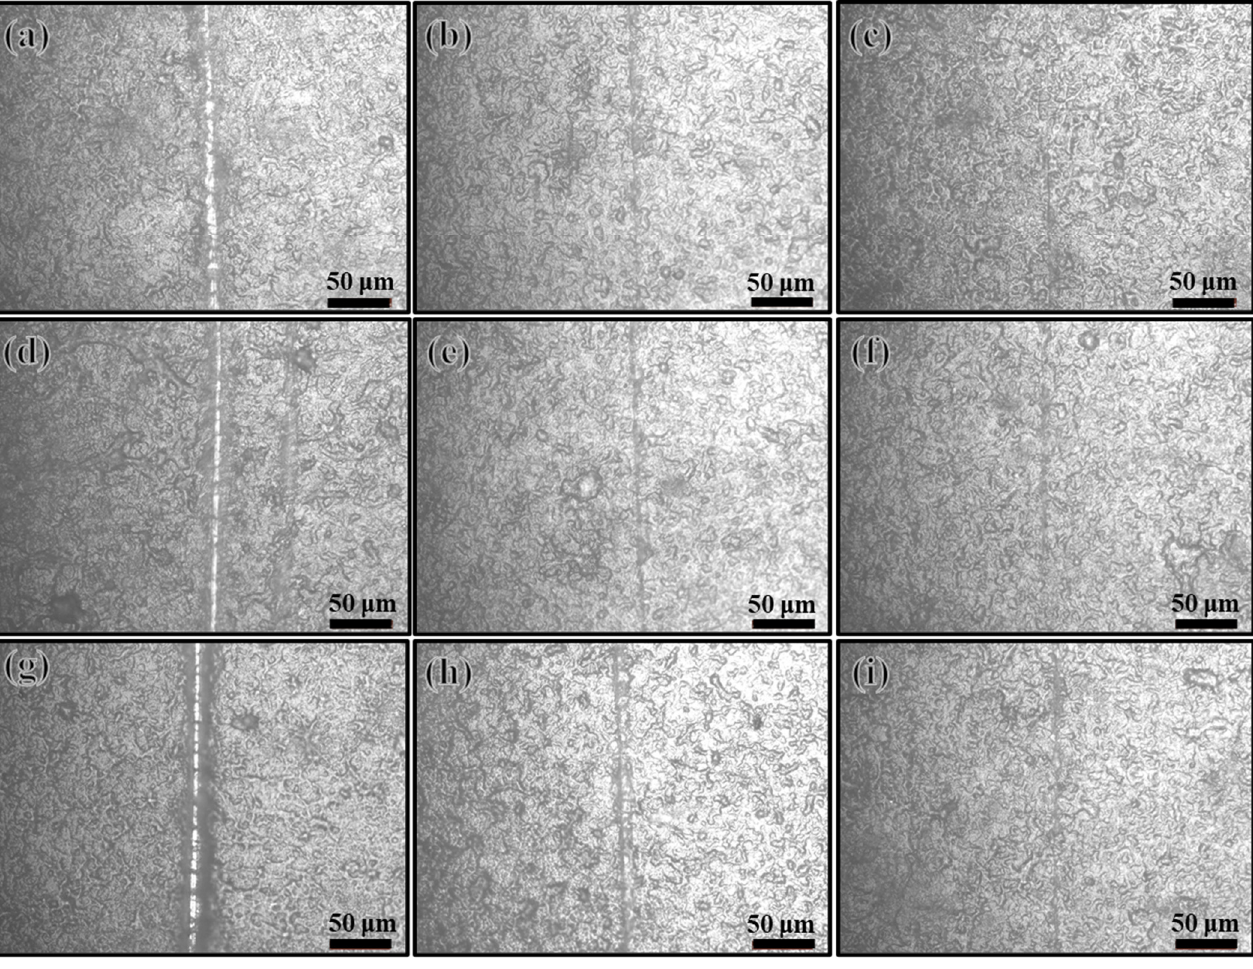
Figure 11. Self-healing tests of samples with different coatings in the presence of water: ( a ) Ce(IV)/PEI/PAA surface incision, ( b , c ) surface morphology of Ce(IV)/PEI/PAA self-healing in the presence of water for 10 and 20 min, ( d ) Ce(IV)/PEI/PAA surface incision, ( e , f ) surface morphology of Ce(IV)/PEI-C/PAA self-healing in the presence of water for 10 and 20 min, ( g ) Ce(IV)/PEI/PAA surface incision, ( h , i ) surface morphology of Ce(IV)/PEI-C/PAA-GO self-healing in the presence of water for 10 and 20 min.